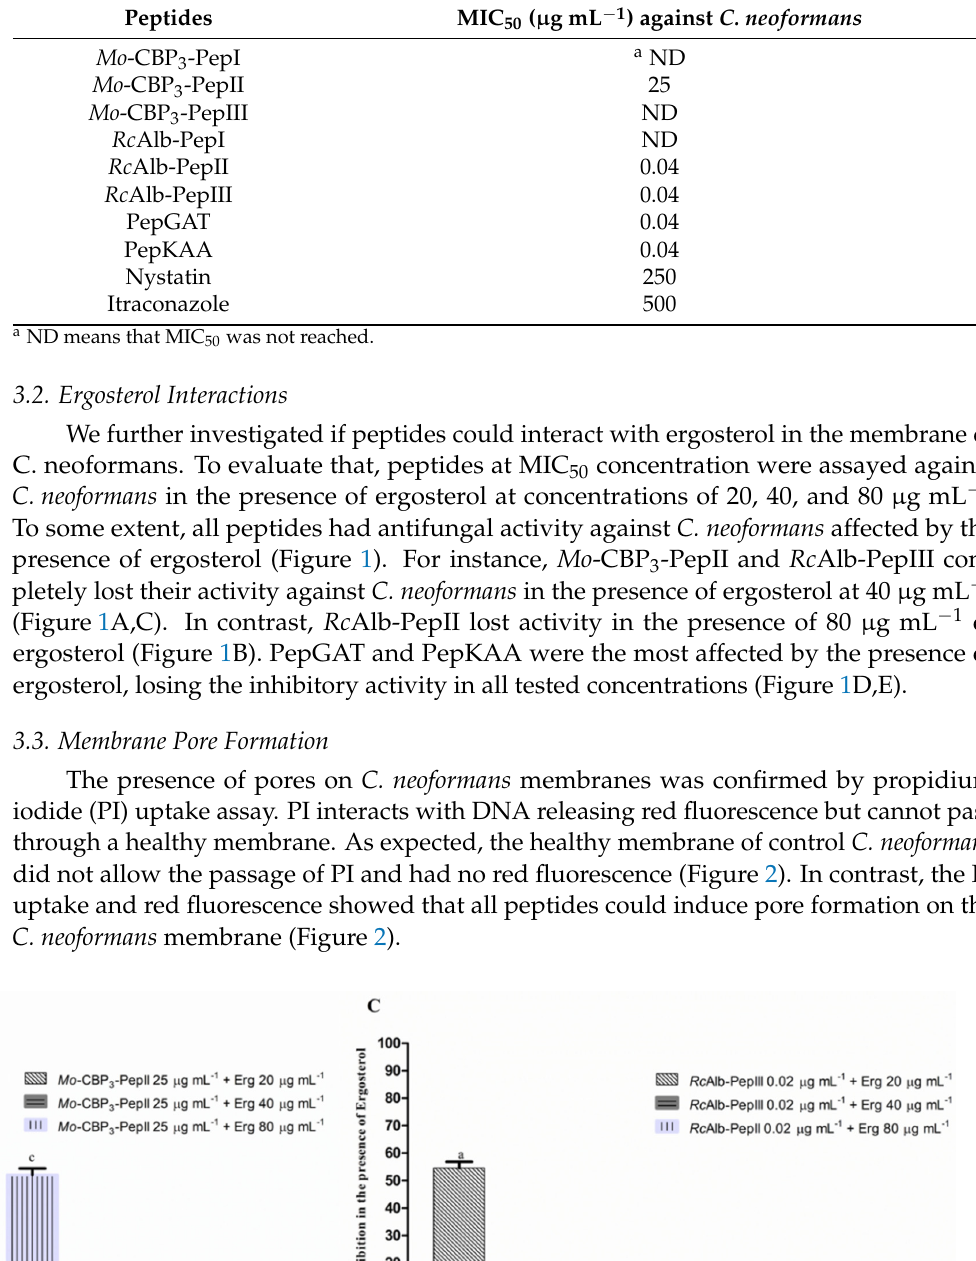
Table 1. Minimum inhibitory concentration (MIC) of synthetic against C. neoformans .